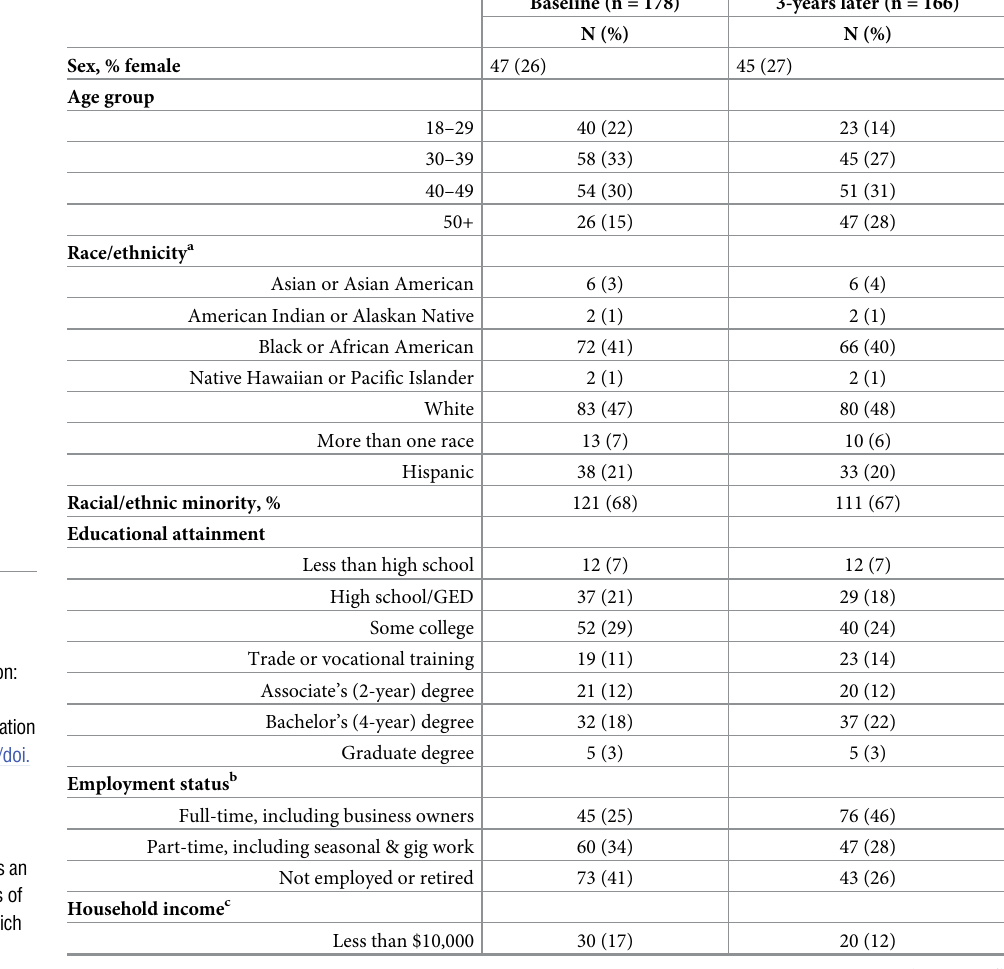
Table 1. Characteristics of HVP study participants (enrolled v.